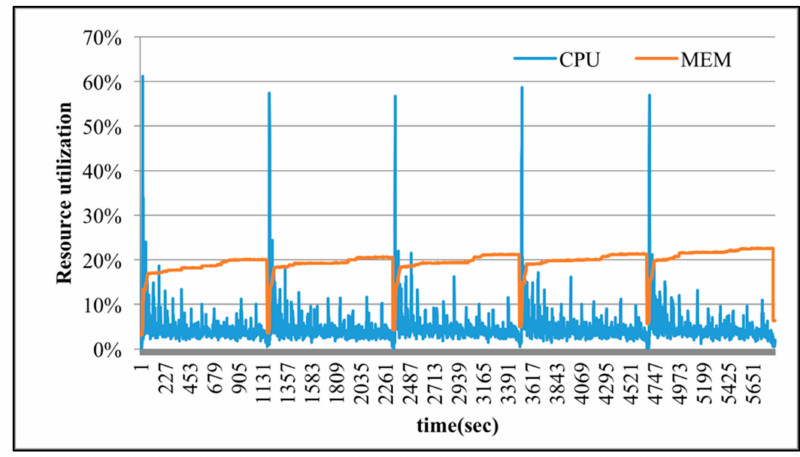
Figure 6. Resource utilization of executing SparkTC without over-commit.